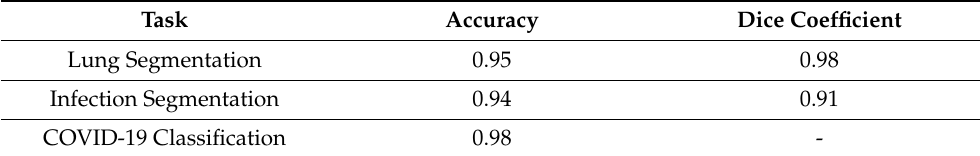
Table 4. Quantitative results among different tasks on testing set in terms of accuracy and Dice Coefficient values.